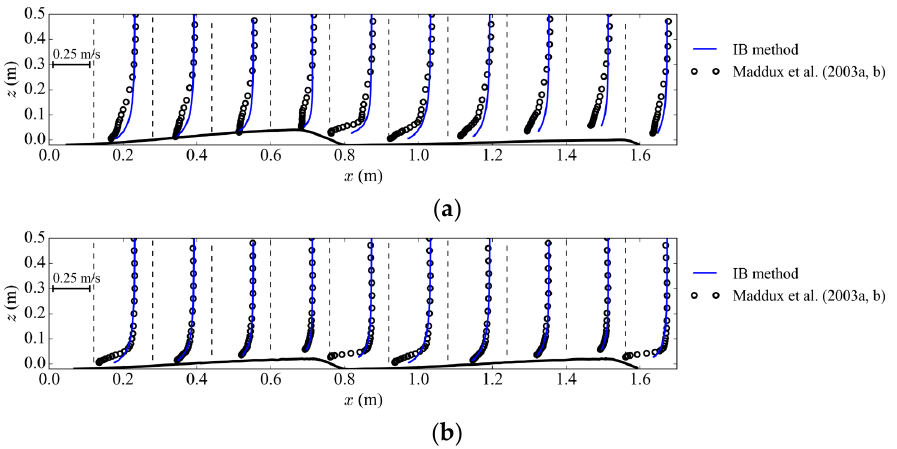
Figure 11. Mesh for flow over 3D dunes.